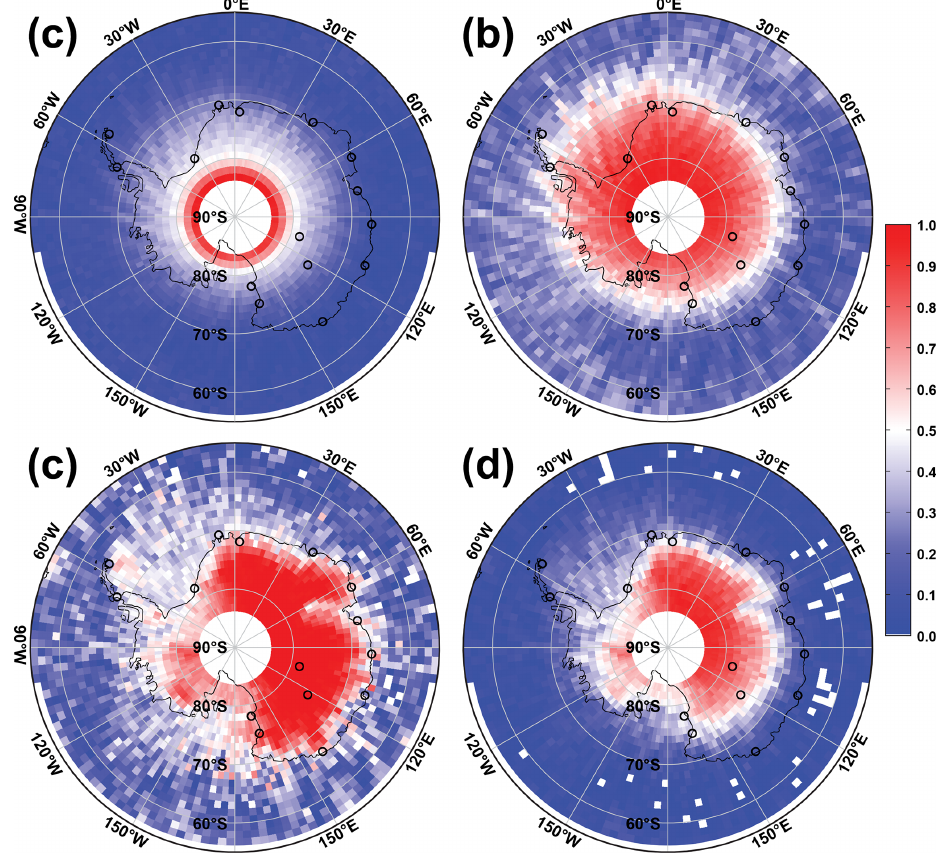
Figure 5. Same as Fig. 2 but for the Antarctic. The display in (a) is scaled to a maximum count of